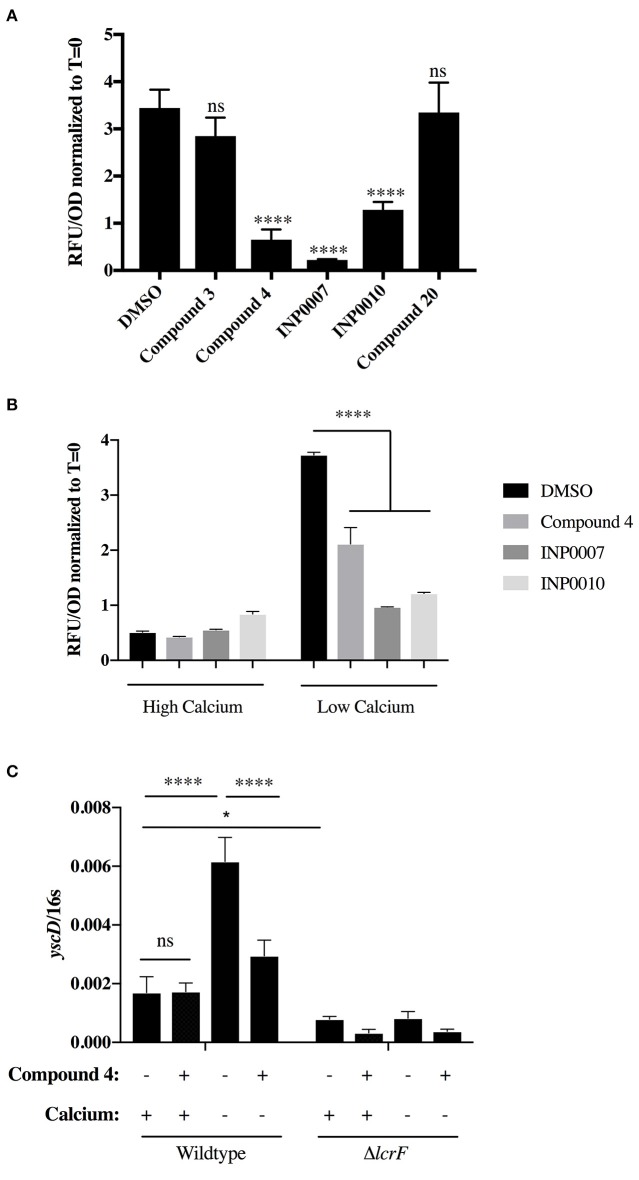
Analysis of yopH-mCherry fluorescence to assess T3SS gene expression. (A,B)
Y. pseudotuberculosis pyopH FLAG mCherry was grown under T3SS-inducing (A,B, low calcium) or non-inducing (B, high calcium) conditions and relative mCherry fluorescence measured at 3 h after addition of 50 μM compound or equivalent volume of DMSO. The average of three biological replicates ± standard deviation is shown and statistical significance is represented comparing compounds relative to the DMSO control. ****P < 0.0001 (one way ANOVA with Dunnett's post-hoc test). (C)
Y. pseudotuberculosis wildtype or ΔlcrF were grown in low or high calcium media for 3 h in 50 μM Compound 4 or equivalent volume of DMSO and yscD mRNA levels measured by qPCR. Expression levels were normalized to 16s rRNA. Statistical significance is represented comparing the indicated pairs of conditions. ****P < 0.0001, *P < 0.002 (Student t-test).